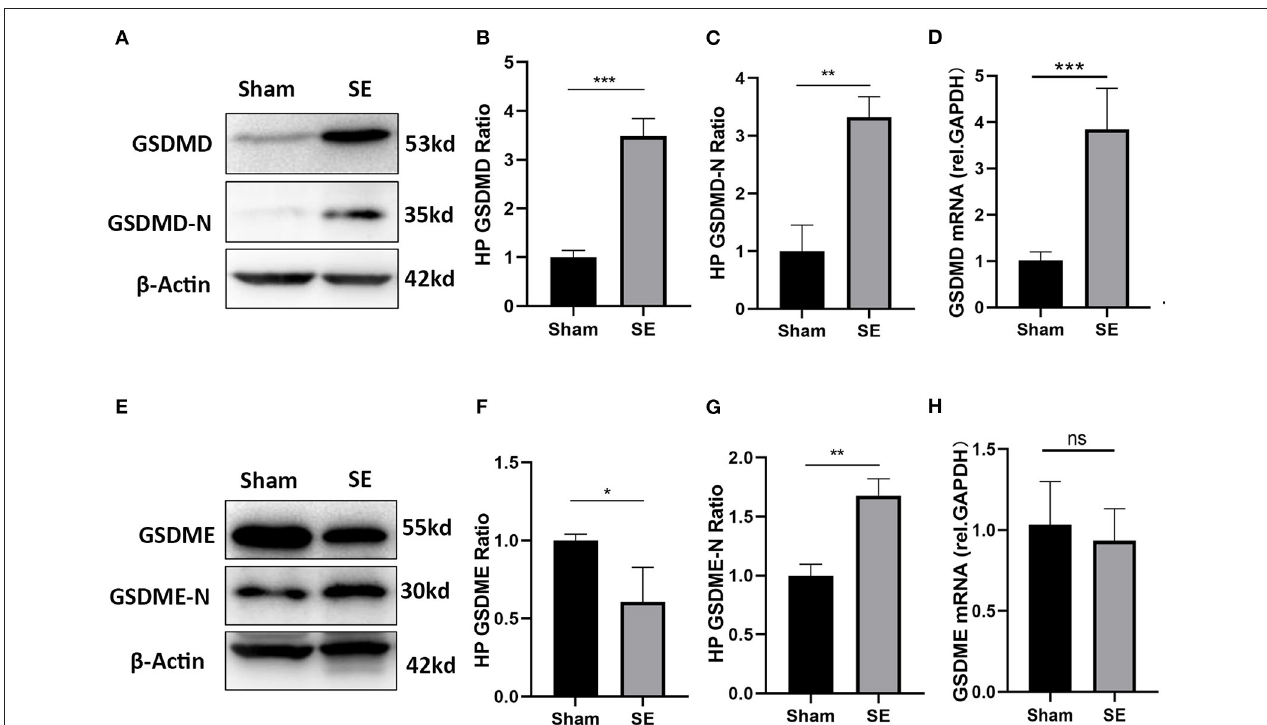
FIGURE 6 | The expression of GSDMD and GSDME in epileptic mice induced by kainic acid. (A) WB bands of GSDMD, GSDMD-N and β -actin proteins in the hippocampus. (B) Statistical analysis results of the hippocampal GSDMD protein expression in the epilepsy group and sham group. (C) Statistical analysis results of the hippocampal GSDMD-N protein expression in the epilepsy group and sham group. (D) Statistical analysis results of the hippocampal GSDMD mRNA expression in the epilepsy group and sham group. (E) WB bands of GSDME, GSDME-N and β -actin proteins in the hippocampus. (F) Statistical analysis results of the hippocampal GSDME protein expression in the epilepsy group and sham group. (G) Statistical analysis results of the hippocampal GSDME-N protein expression in the epilepsy group and sham group. (H) Statistical analysis results of the hippocampal GSDME mRNA expression in the epilepsy group and sham group ( n = 3 in each group, * P < 0.05, ** P < 0.01, and *** P < 0.001; HP,